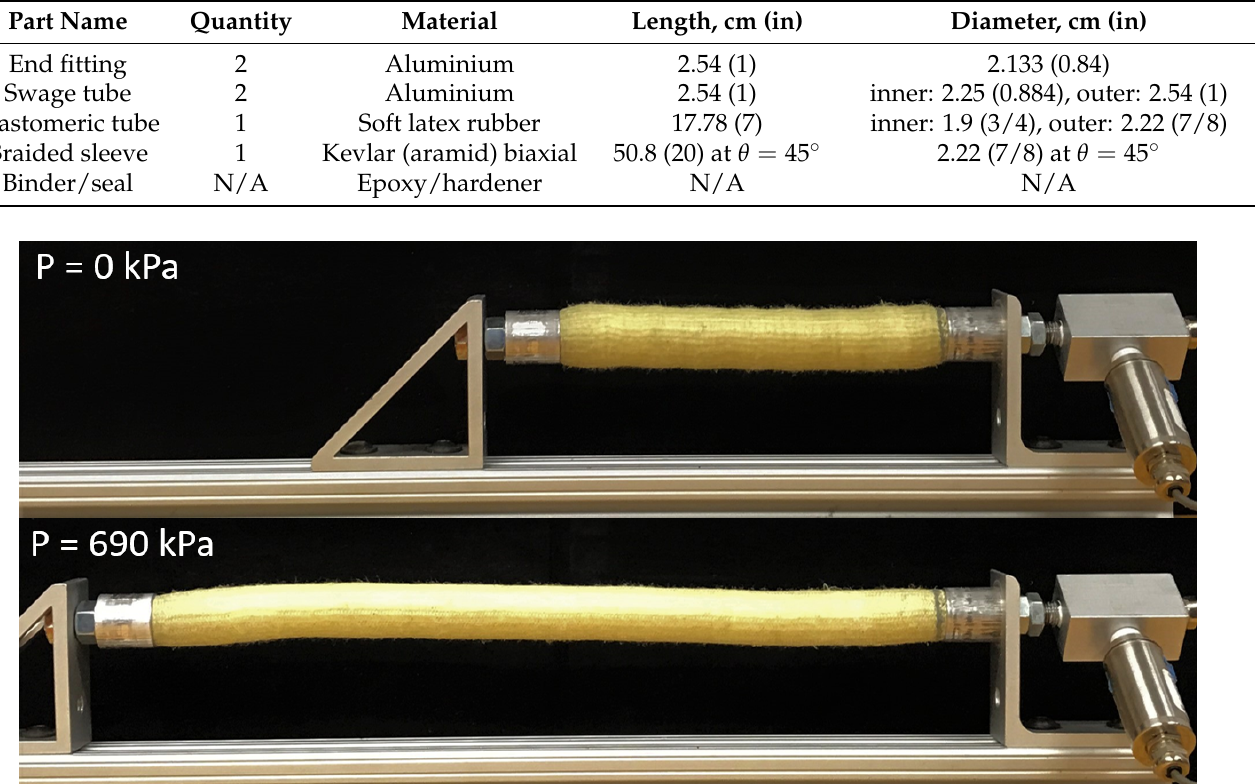
Figure 4. Manufactured and cycled extensile fluidic artificial muscle. The excess of the sleeve accumulated in arbitrary regions along the actuator. The diameter was not uniform along the axis of the